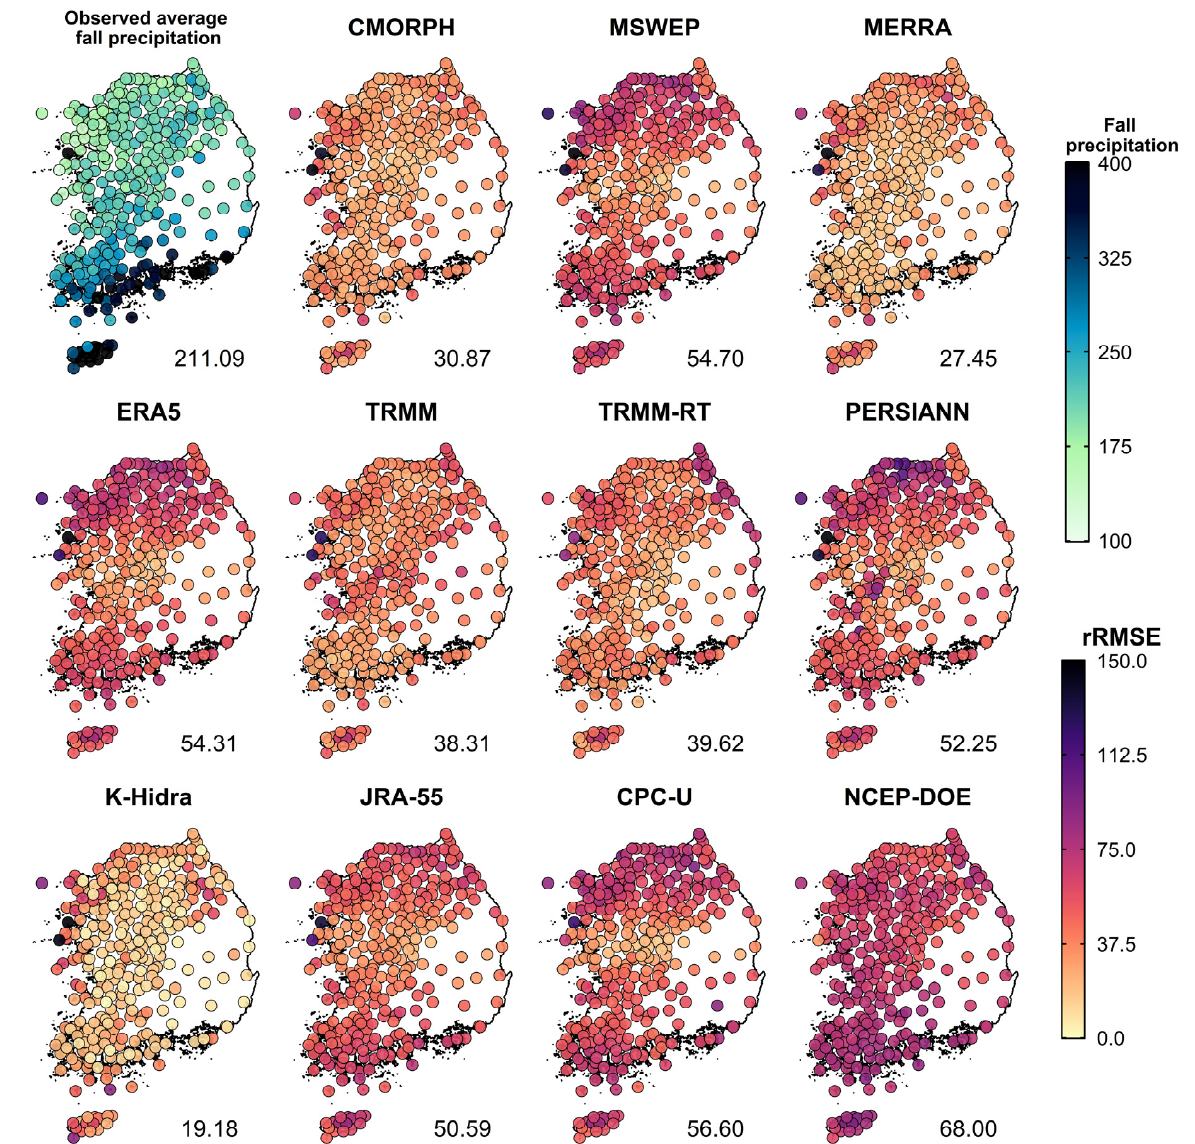
Figure 5. As in Figure 4 but for fall (SON)